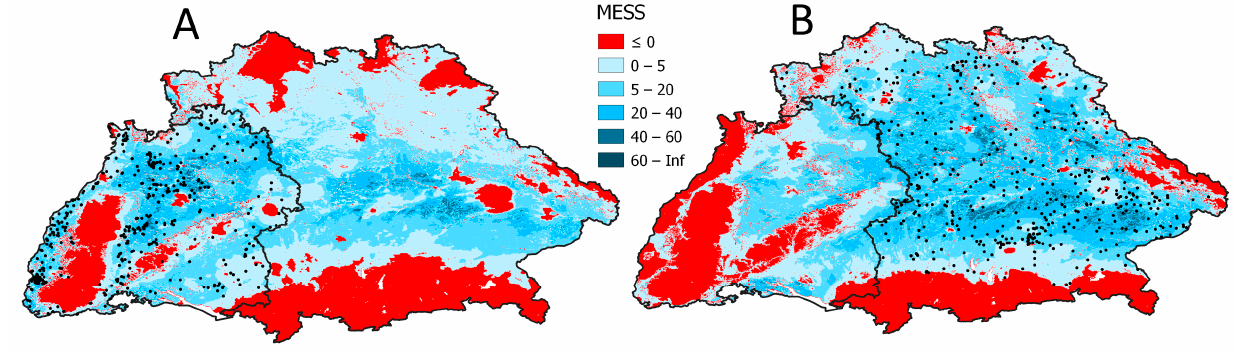
are colored in red. Black dots show sampling locations.